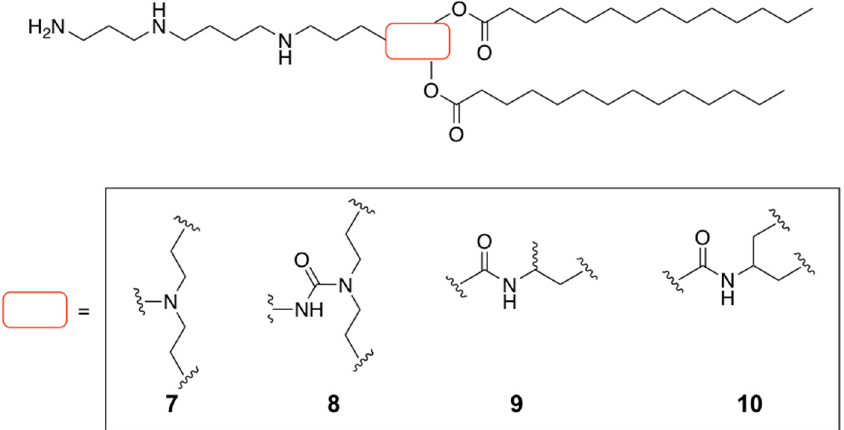
Figure 3. Design of a small library of spermine-based cationic lipids modifying the central core.